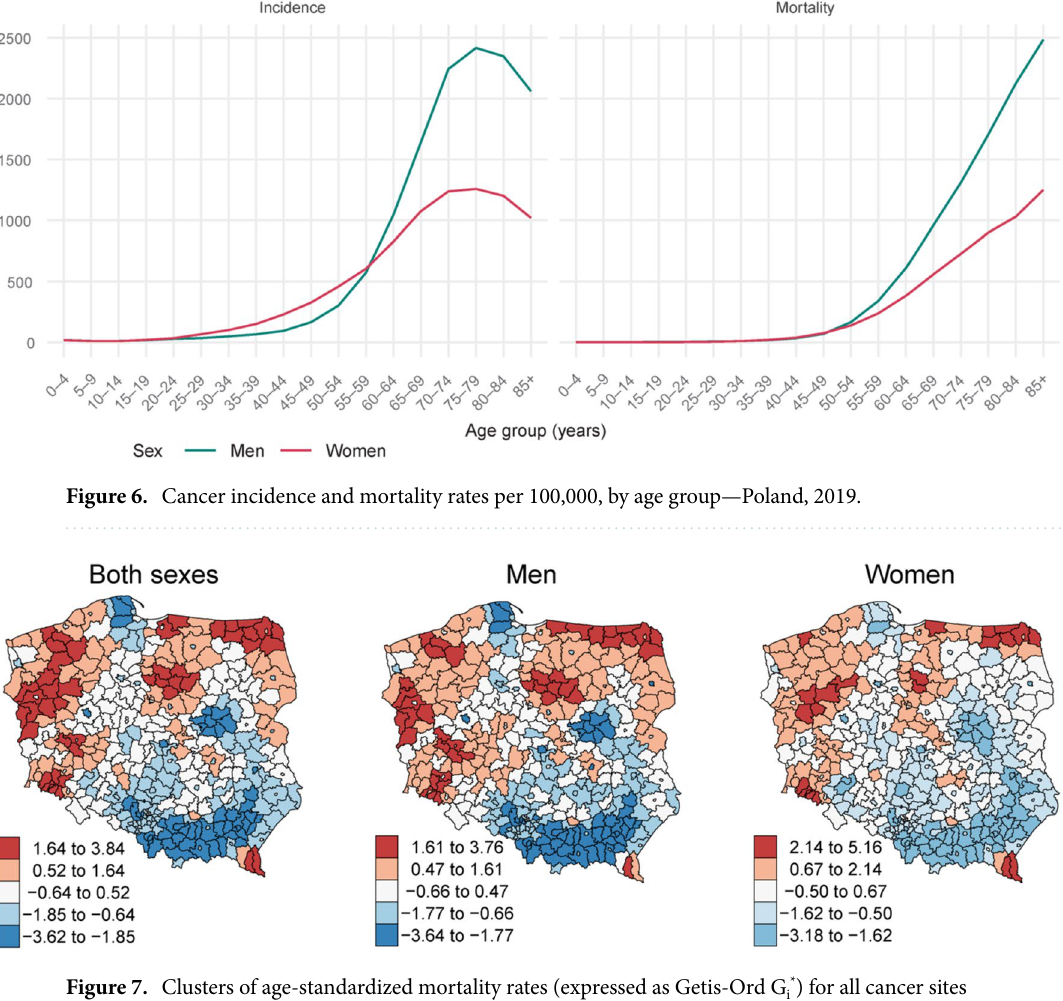
Figure 7. Clusters of age-standardized mortality rates (expressed as Getis-Ord G i * ) for all cancer sites aggregated, powiat level—Poland,